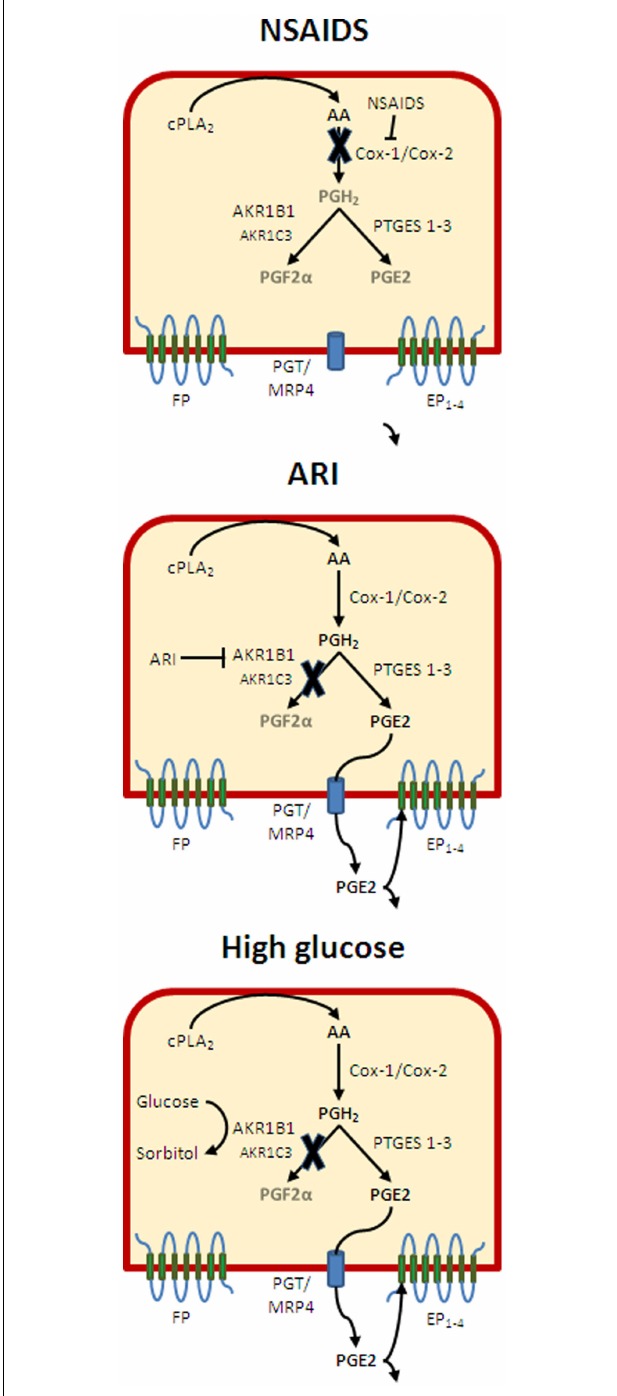
FIGURE 9 | Regulation of PGs of the relative PGE2 and PGF2 α release in endometrial cells. Following activation of endometrial cells with the cytokine IL-1 β , several enzymes leading to the production of PGF2 α and PGE2 exhibit increased expression and/or activity.Treatment of cells with NSAIDs will inhibit the generation of PGH2 at the level of COX-1 and COX-2, thus blocking the release of both PGF2 α and PGE2 without an alteration of the relative production of the two PGs. Inhibition of AKR1B1